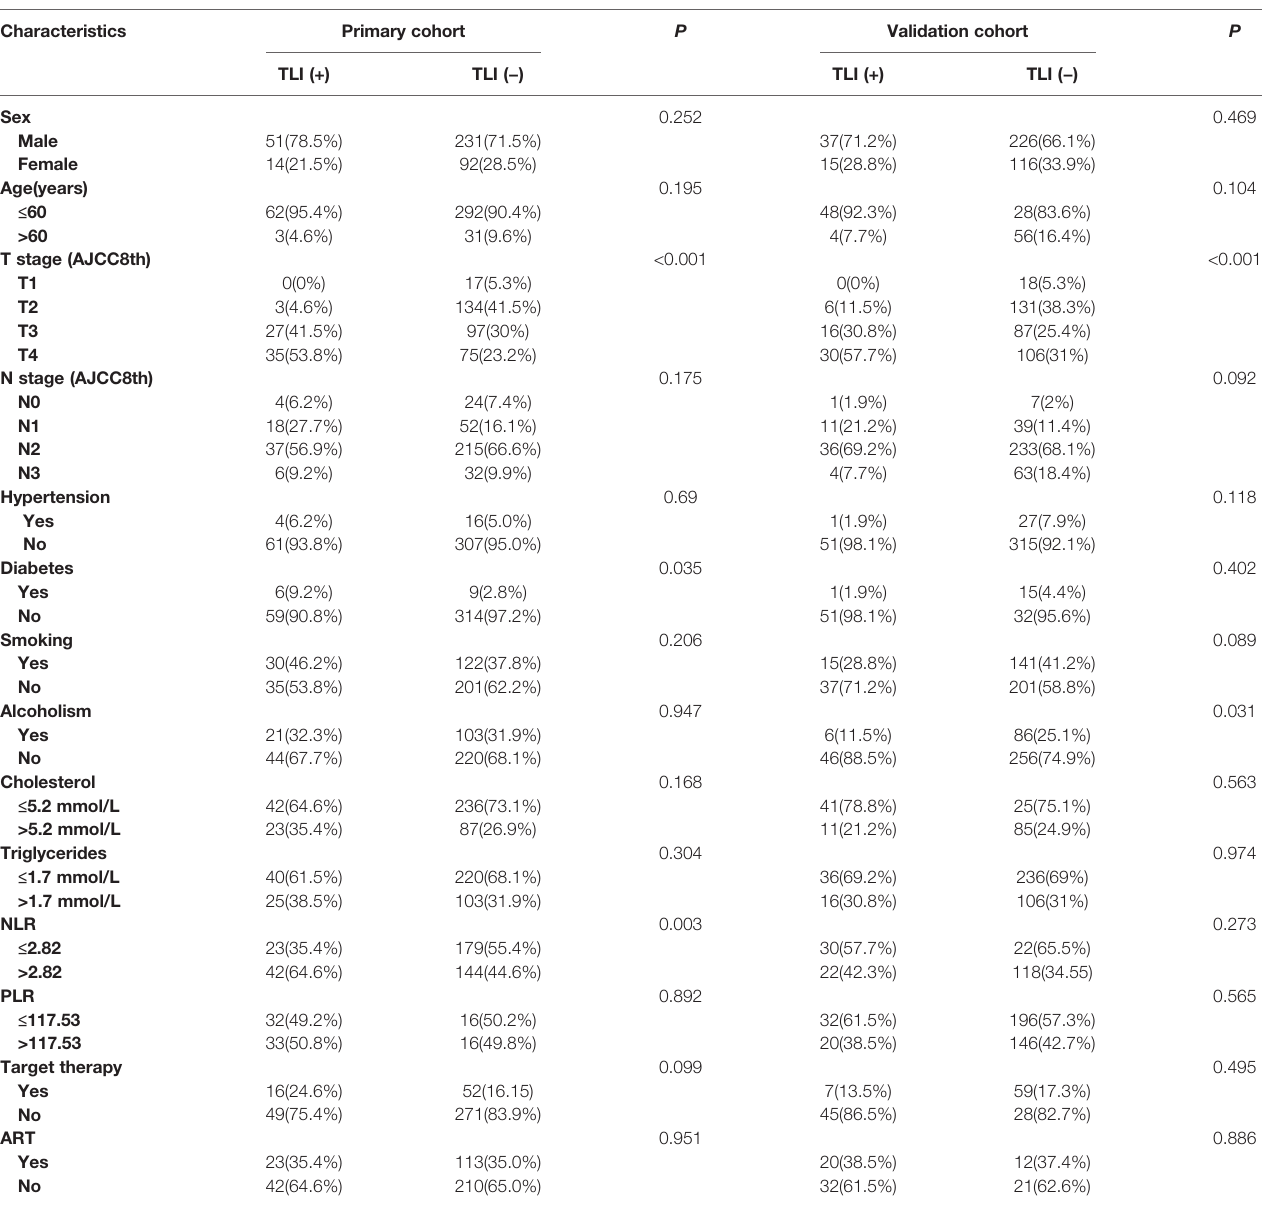
TABLE 3 | Univariate analysis of temporal lobes in primary and validation